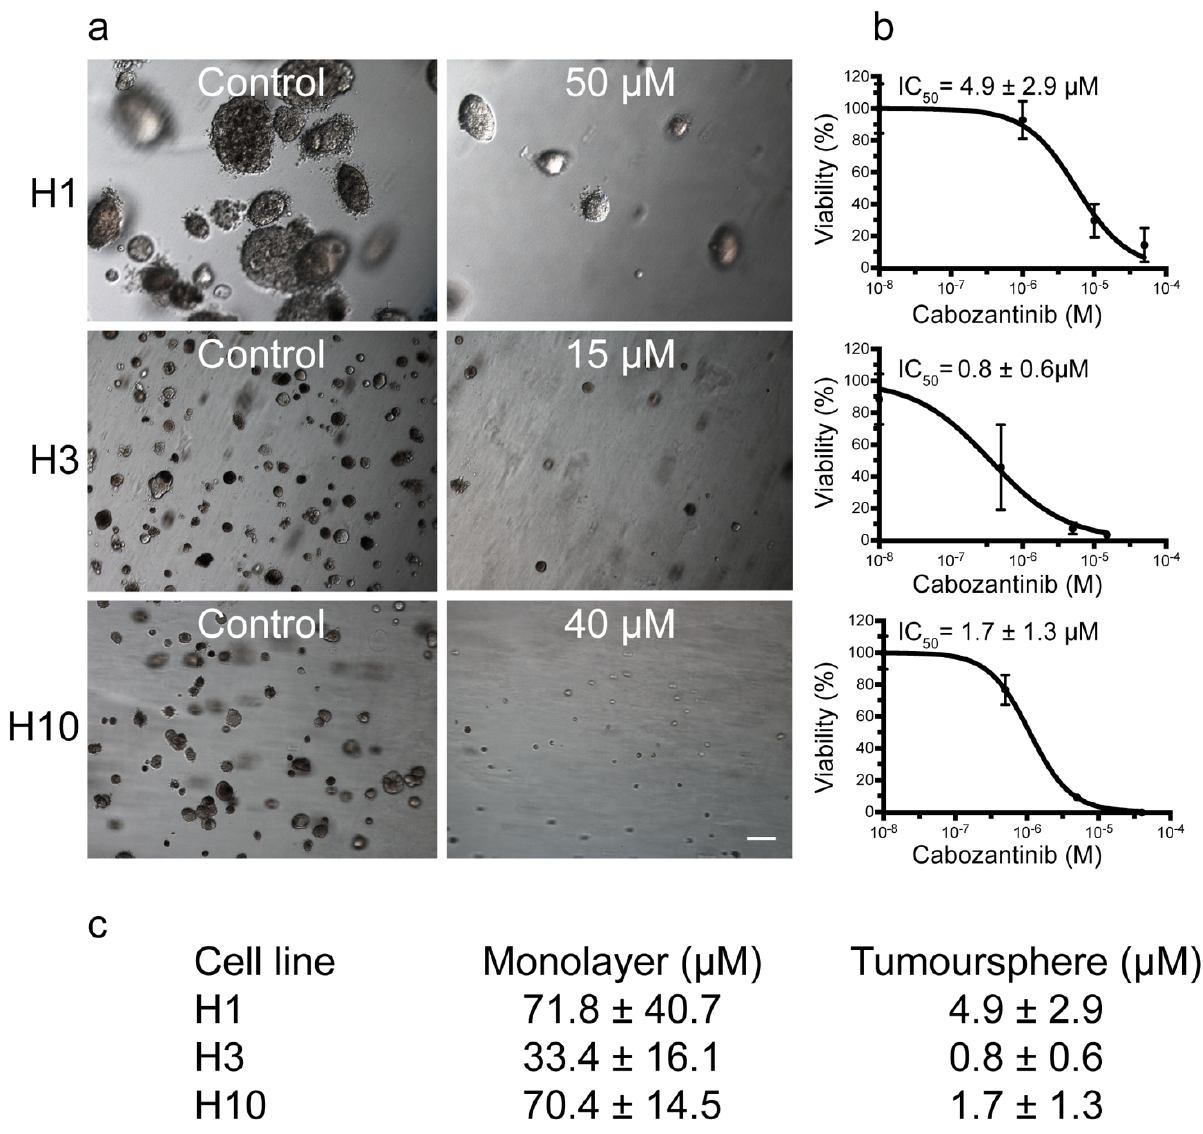
Figure 2. Cabozantinib inhibits colony formation and anchorage-independent growth in MBM cell lines. ( a ) Representative phase-contrast images (10 × objective) at day 14 of H1, H3 and H10 colonies grown in soft agar, either untreated (control) or treated with 50 μ M (H1), 15 μ M (H3) or 40 μ M (H10) cabozantinib. Scale bar = 100 μ m. ( b ) Representative viability curves of cells grown as 3D cultures after treatment with cabozantinib with increasing doses. ( c ) Table showing the calculated IC 50 values of cabozantinib in monolayer cell viability assays and tumorsphere cell viability assays.